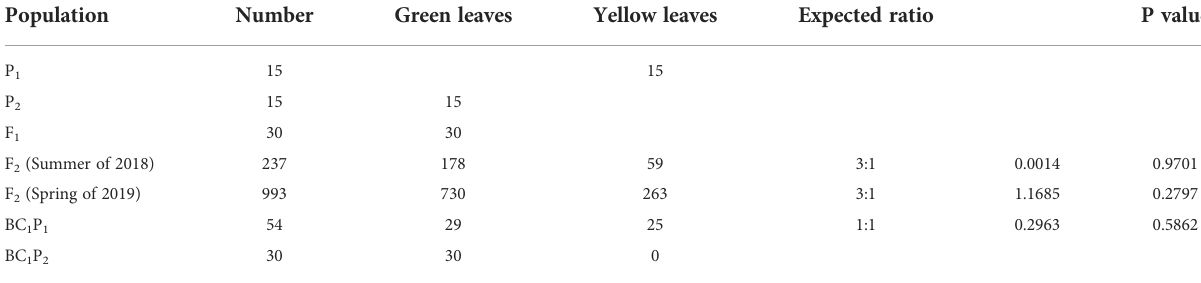
TABLE 1 Phenotype of yellow mutant to green leaf trait and Chi-square goodness- fi t test ratios in different populations. Population Number Green leaves Yellow leaves Expected ratio P